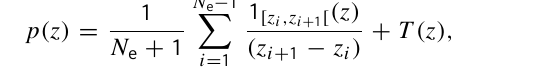
Fig. 4. Same as Fig. 2, but for the RHF.